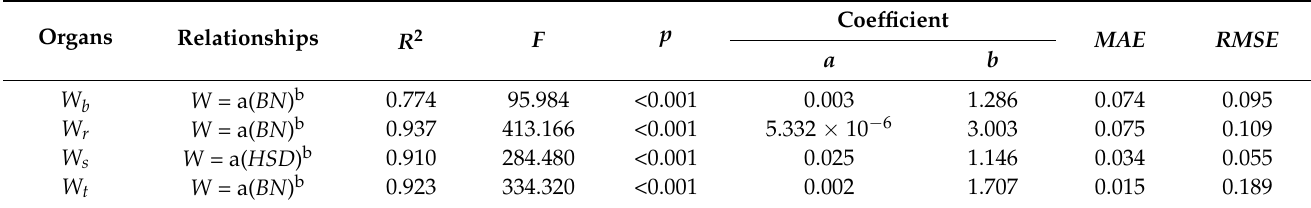
Table 2. Optimum biomass relationships of Sargassum fusiforme.